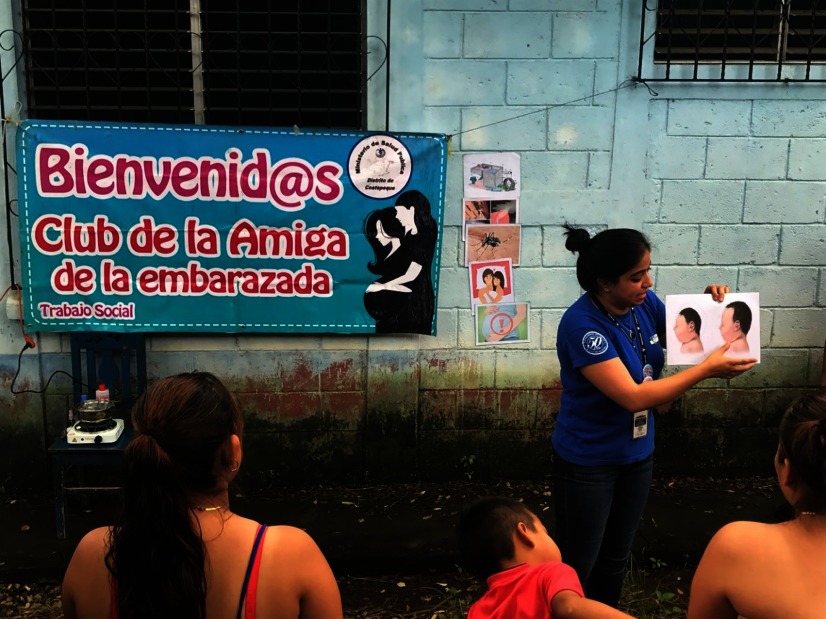
An APROFAM community health worker in Guatemala teaches members of a community-based discussion club for pregnant women about the risks of Zika and corresponding prevention strategies. © 2017 Skye Beare/IPPFWHR